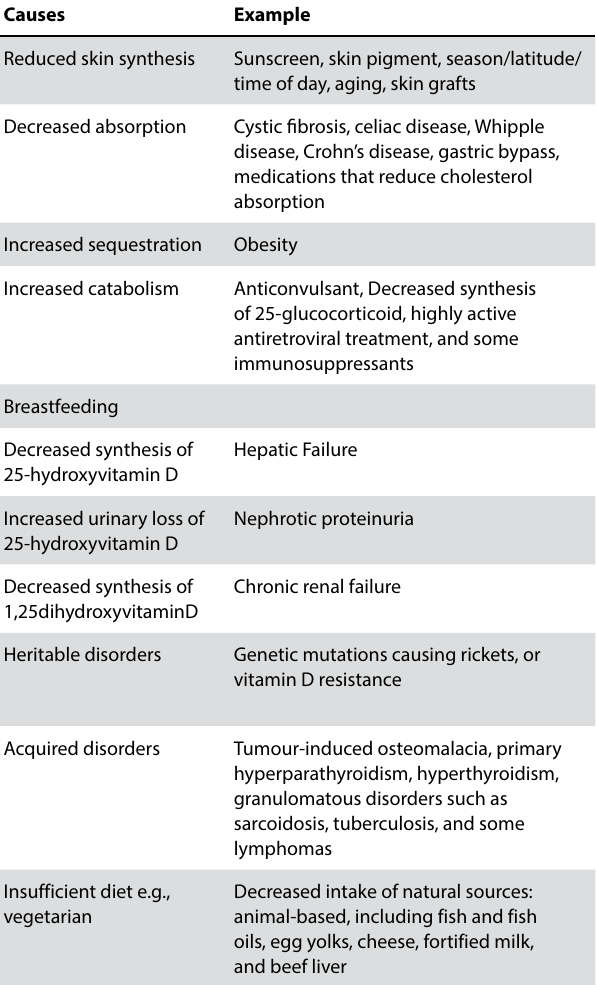
Table 1. Other Causes of Vitamin D Deficiency Causes